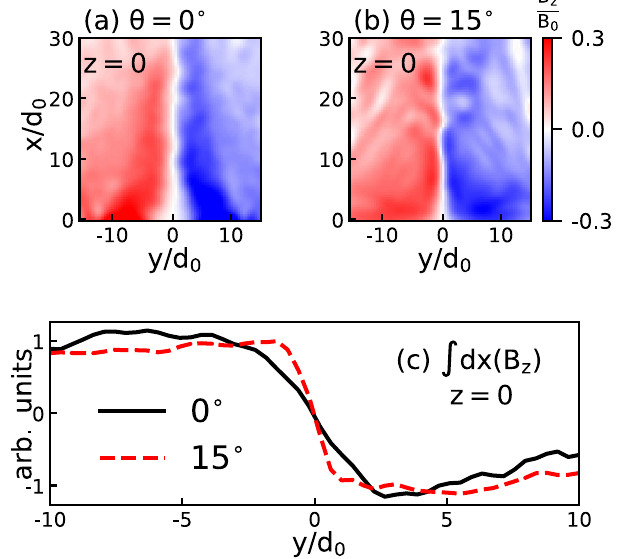
Fig. 4| Simulated evidencefor magnetic fi eldcompressioninthepresenceofa guide fi eld. Centralcutof theanti-parallelcomponentof themagnetic fi eld (inthe xy plane, see Fig. 1 for the geometry), as retrieved from the 3D simulations, for Ω θ =0 ∘ -( a ) and θ =15 ∘ -( b ) at t Ω 0 =20, where 0 is the ion gyrofrequency (see Methods). This represents the B z fi eld across the contact region between the two counter-streamingmagnetizedplasmaplumes.Panel c displaysthepath-integrated (along x ) B z - fi eld passing by the contact region at t Ω 0